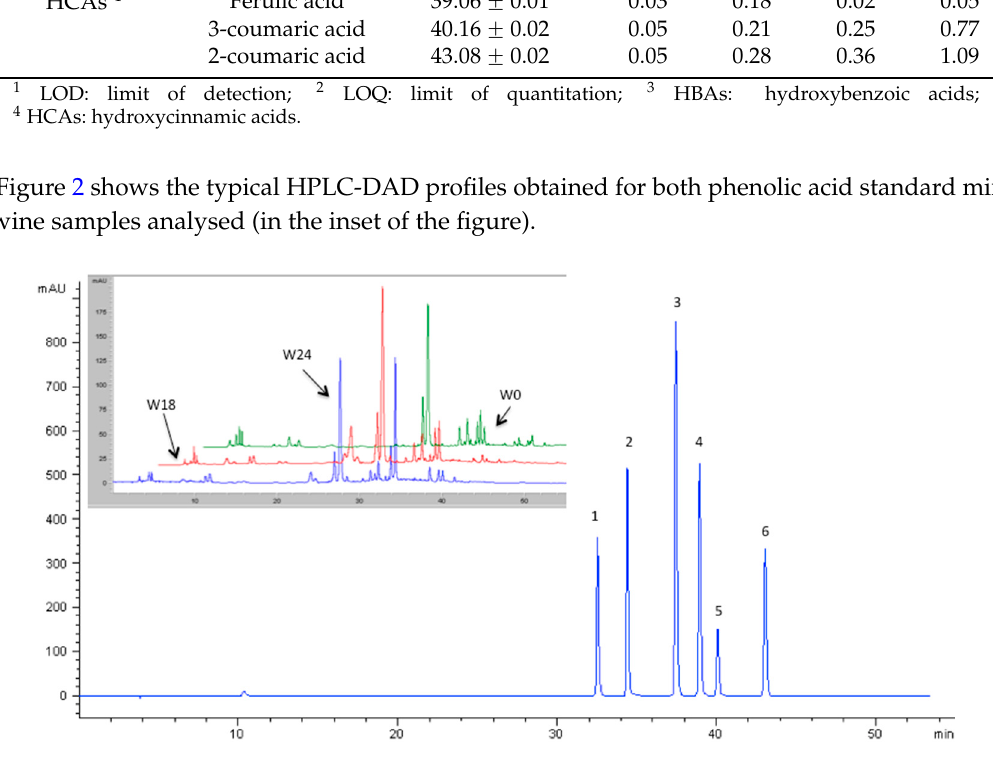
Table 2. Validation parameters for the analysed bioactive compounds using pure standards. Chemical Class Compound Retention Time